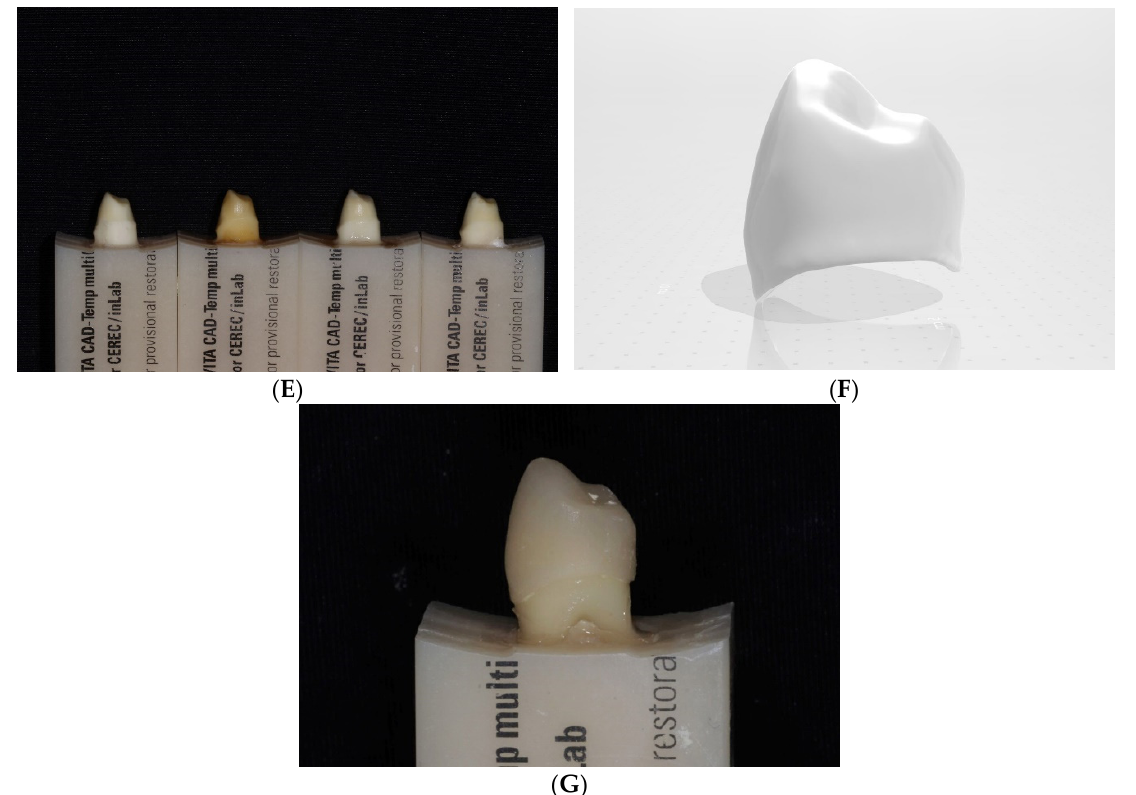
Figure 1. Standardization of tooth abutment: ( A ):VITA CAD-Temp multiColor block (left); schematic diagram for cutting block (right). ( B ): Mandibular premolar tooth (left); block with tooth placed inside (right). ( C ): The STL file of prepared teeth for standardization. ( D ): Tooth abutment fabricated using milling machine. ( E ): Standardized tooth abutments. ( F ): The STL file of the crown shape for standardization. ( G ): Specimen with crown cemented to tooth abutments. STL, standard tessellation language.